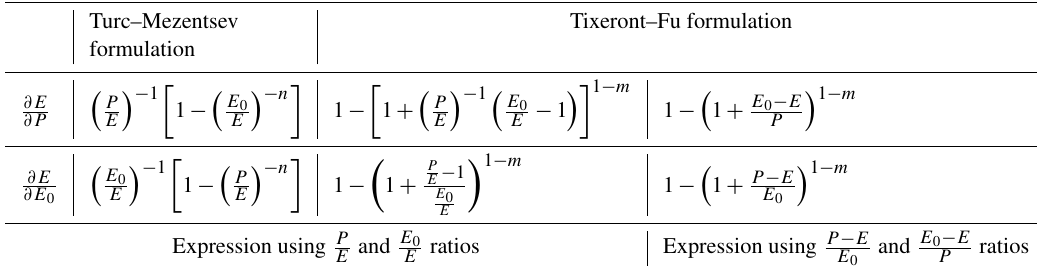
Table 6. Comparison of the partial differentials of the Turc–Mezentsev and Tixeront–Fu formulas ( P – precipitation, E 0 – maximum evap- oration, E – actual evaporation, all in mmyr − 1 averaged over many years; n is the free parameter of the Turc–Mezentsev formula ( n > 0); m is the free parameter of the Tixeront–Fu formula ( m >